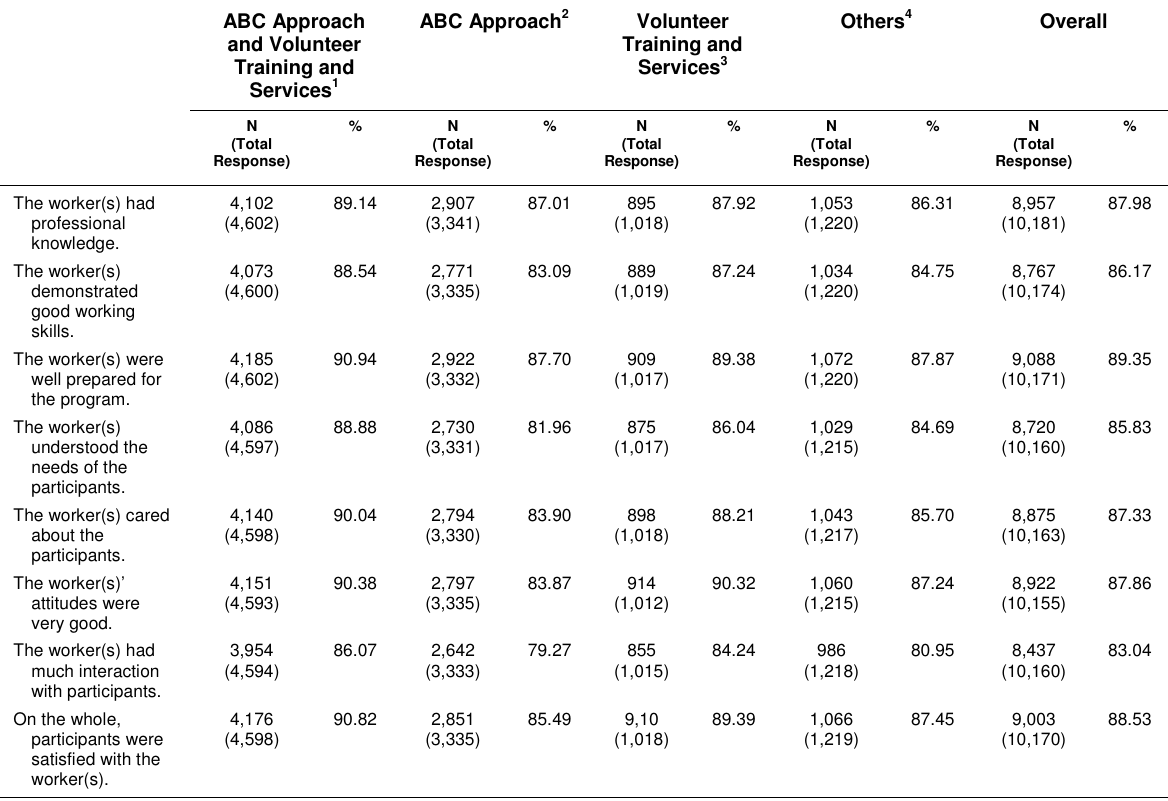
Comparison of the Positive Views Towards the Tier 2 Program Workers Among Different Program